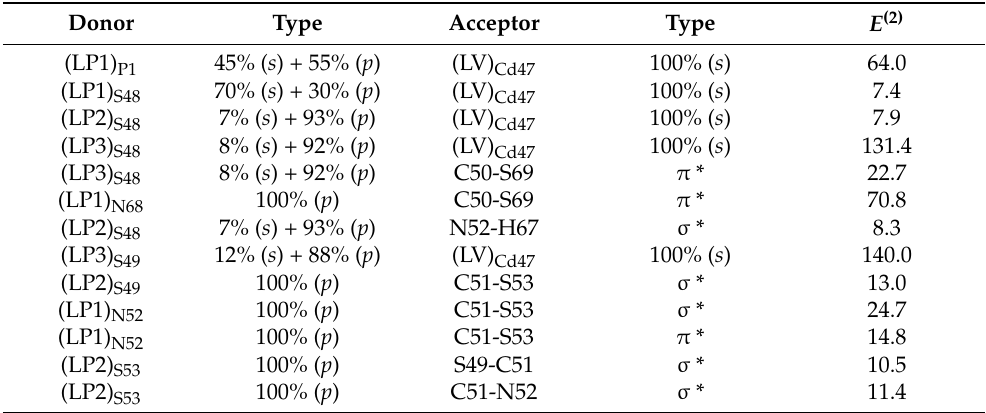
Table 6. Second order perturbation energies for charge transfers from donor to acceptor orbitals in Cd(2) .